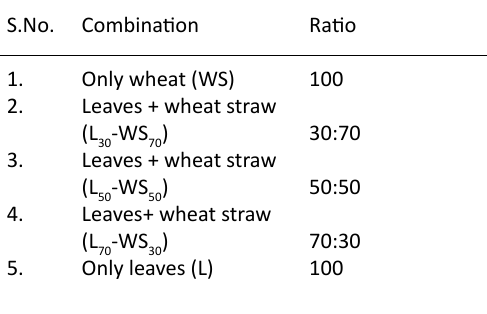
Table 1. Different combinations of substrates used for spawning S.No.